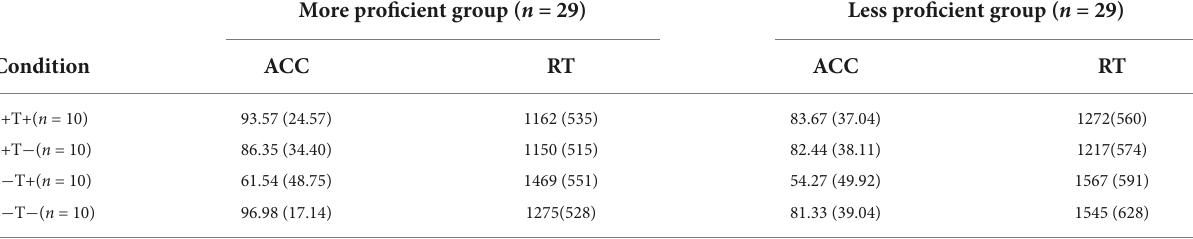
TABLE 2 Mean reaction time (RT, in ms) and accuracy (ACC, in %) of the two proficiency groups in semantic relatedness judgment.